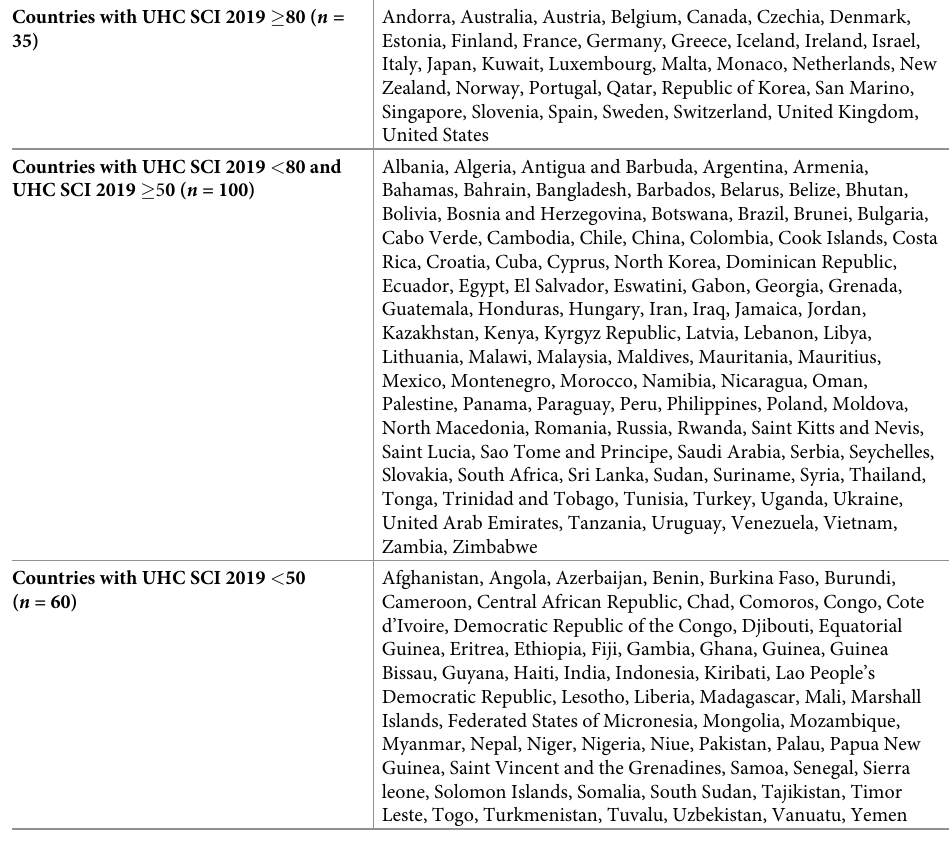
Table 1. Countries with UHC SCI 2019 � 80 and UHC SCI 2019 <